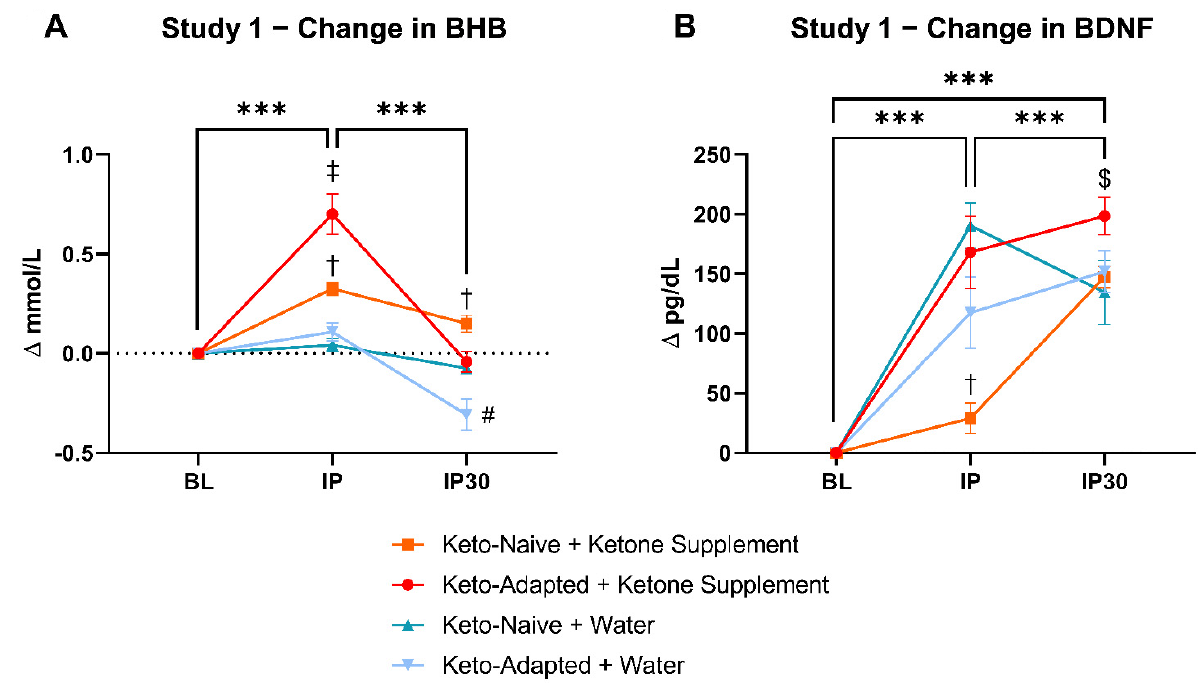
Figure 1. Study 1 BHB and BDNF Changes. Two unique groups (Keto-adapted vs. Keto-naïve) were enrolled in parallel and crossed over to receive either a KS or WT before exercise. Capillary BHB was normalized to baseline and analyzed for covariance (ANCOVA) using a 4 (condition) × 3 (time) model. BHB increased acutely from BL to post exercise in KS conditions only, with additive effects in the keto-adapted cohort, followed by a sharp decrease to baseline values by IP30 ( A ). Plasma BDNF was normalized to baseline and analyzed for covariance (ANCOVA) using a 4 (condition) × 3 (time) model. BDNF increased acutely from baseline to immediately post-exercise ( ∆ = 126 ± 12 pg/dL; +54%; p < 0.001) and 30 min thereafter ( ∆ = 158 ± 12 pg/dL; +63%; p < 0.001). The KN + KS condition stimulated less BDNF than KA + KS ( p < 0.001) and KN + WT ( p = 0.007), but not KA + WT ( p = 0.214) ( B ). Time effects: *** p < 0.001. † = KN + KS different than all conditions at IP ( p < 0.05). ‡ = KA + KS different than all conditions at IP ( p < 0.05). # = KA + KS different than all conditions at IP30 ( p < 0.05). $ = KA + KS different than KN + WT at IP30 ( p < 0.05). BL, baseline; IP, immediately post-exercise; IP-30, immediately post 30 min after exercise